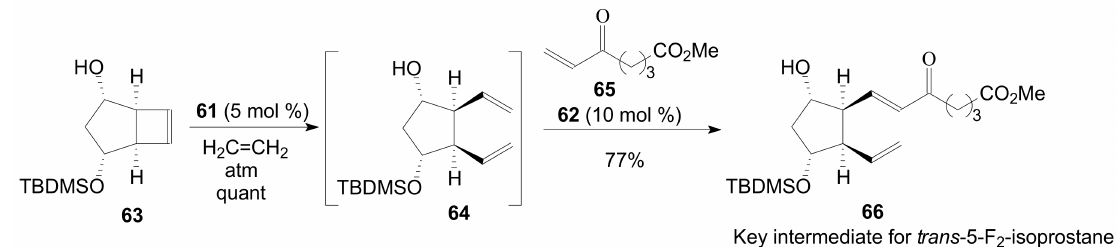
Scheme 12. Synthesis of the key intermediate 66 by RCM for obtaining trans-5-F 2